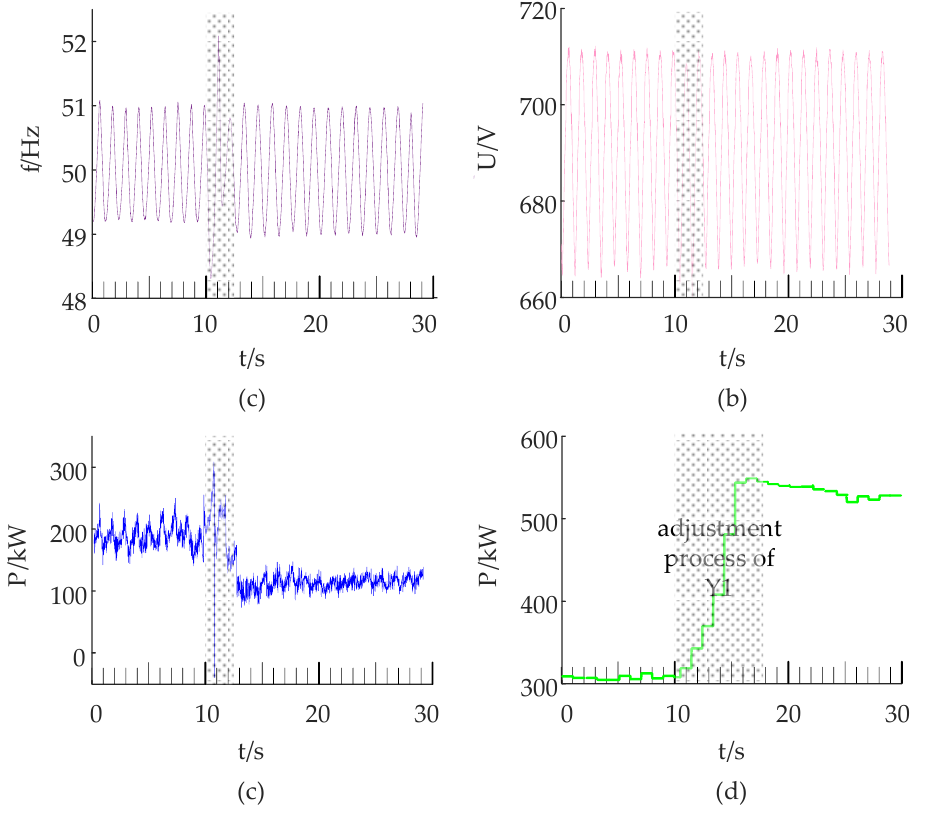
Figure 10. ( a ) system frequency, ( b ) system voltage, ( c ) active power of Gd, ( d ) active power of